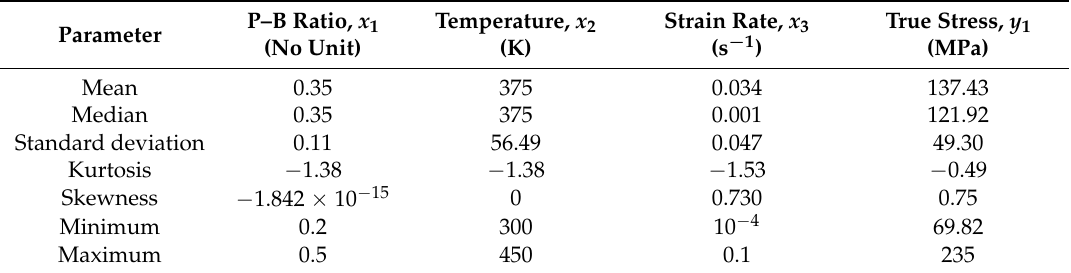
Table 3. Descriptive statistics of true stress data from FE